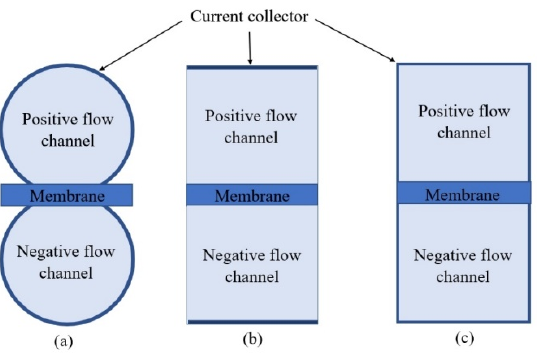
Figure 5. Model geometry design with two channels separated by a membrane. ( a ) Circular channel, ( b ) box-shaped with the linear current collector, and ( c ) box-shaped with the extended current col- lector.